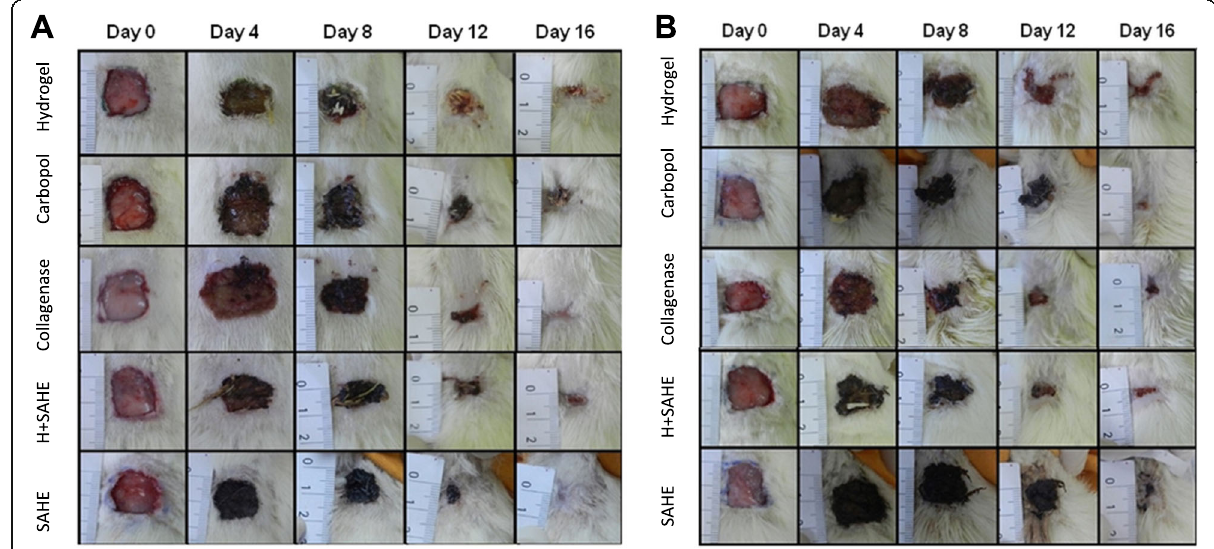
Fig. 2 Cutaneous wound contraction measurements in the rats on days 4, 8, 12, and 16. Image of the lesions in the non-diabetic animals ( a ) and in the diabetic animals ( b ), shown in days of the respective treatments: Hydrogel, Carbopol, Collagenase with Chloramphenicol®, H + SAHE, and